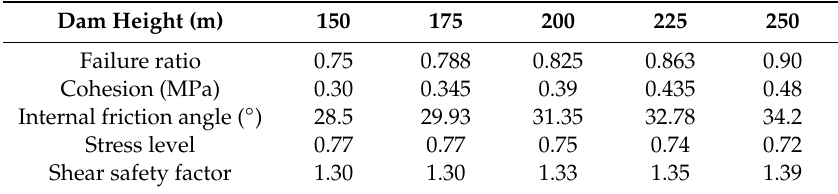
Table 6. Stress levels and shear safety factors of ACC with di ff erent dam